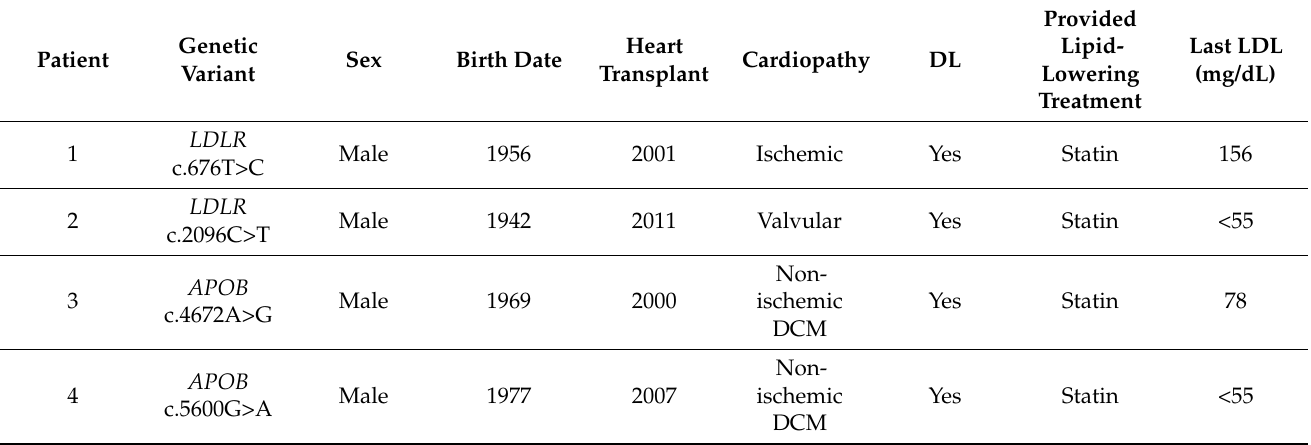
Table 2. Clinical characteristics of patients harboring rare variants associated with familial hyperc-